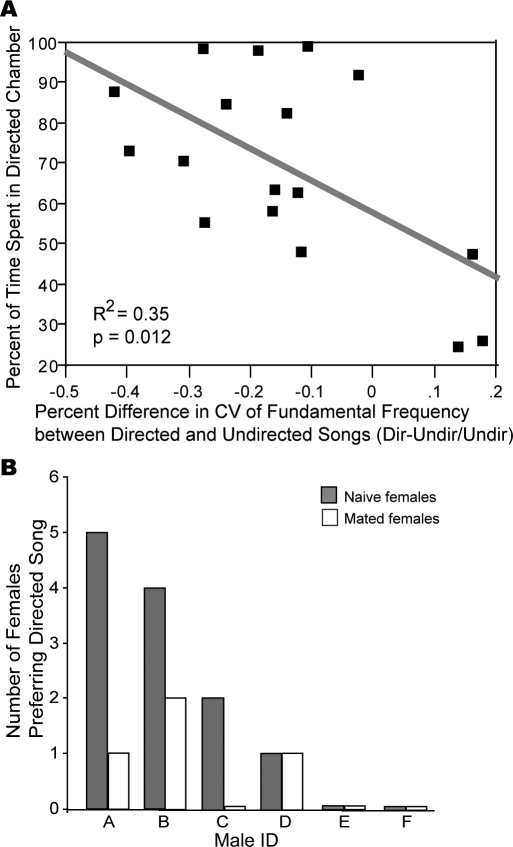
Song Variability and Singer Identity Influence Preferences for Directed Song(A) Plot of the correlation between the percent of time females spent in the directed chamber and the percent difference between the directed and undirected stimuli in the CV of the fundamental frequency of harmonic stacks. When the CV was higher in directed songs than in undirected songs, the preference for directed song was weaker than when the CV was higher in undirected songs.(B) Whether females responded to unfamiliar songs depended on which male the songs came from. Graphed is the number of naive (gray bars) and mated (open bars) females that showed a preference for the directed songs of each of the six unfamiliar males. Overall, there was a significant effect of stimulus male on the responses of naive females (p < 0.05) but not a significant effect on the responses of mated females.